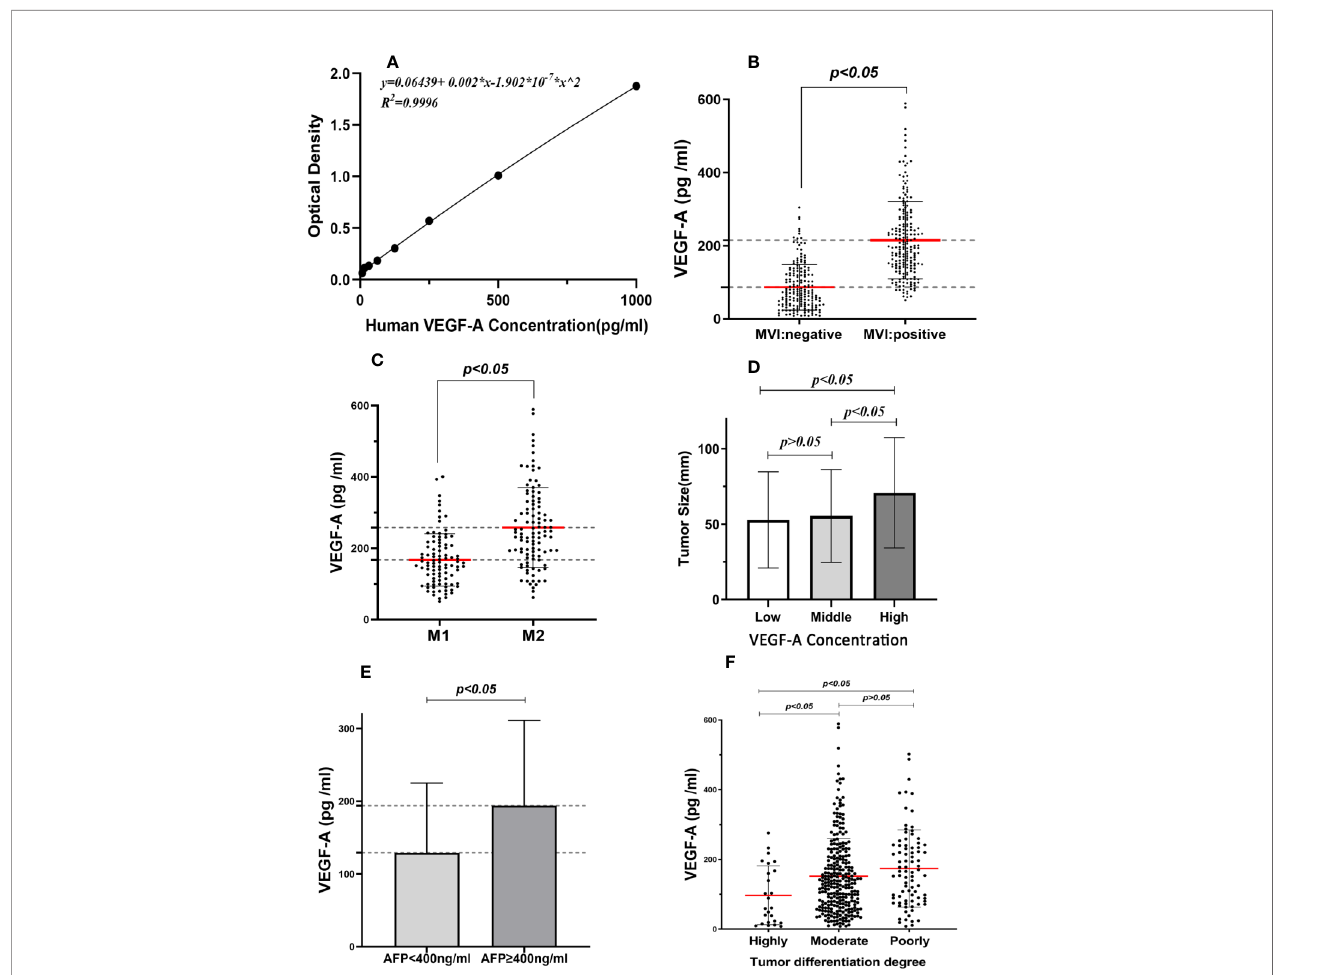
FIGURE 3 | Association between serum VEGF-A expression and clinicopathological factors. (A) Standard curve of OD values and the VEGF-A concentration. (B) Serum VEGF-A levels in MVI positive group was higher than MVI negative group. (C) The mean VEGF-A concentration was signi fi cantly difference between M1 group and M2 group. (D) The expression of VEGF-A was associated with larger tumor size. (E) Pretreatment VEGF-A levels were higher in patients whose preoperative serum AFP >400 ng/ml. (F) The highly differentiated tumors expressed lower VEGF-A